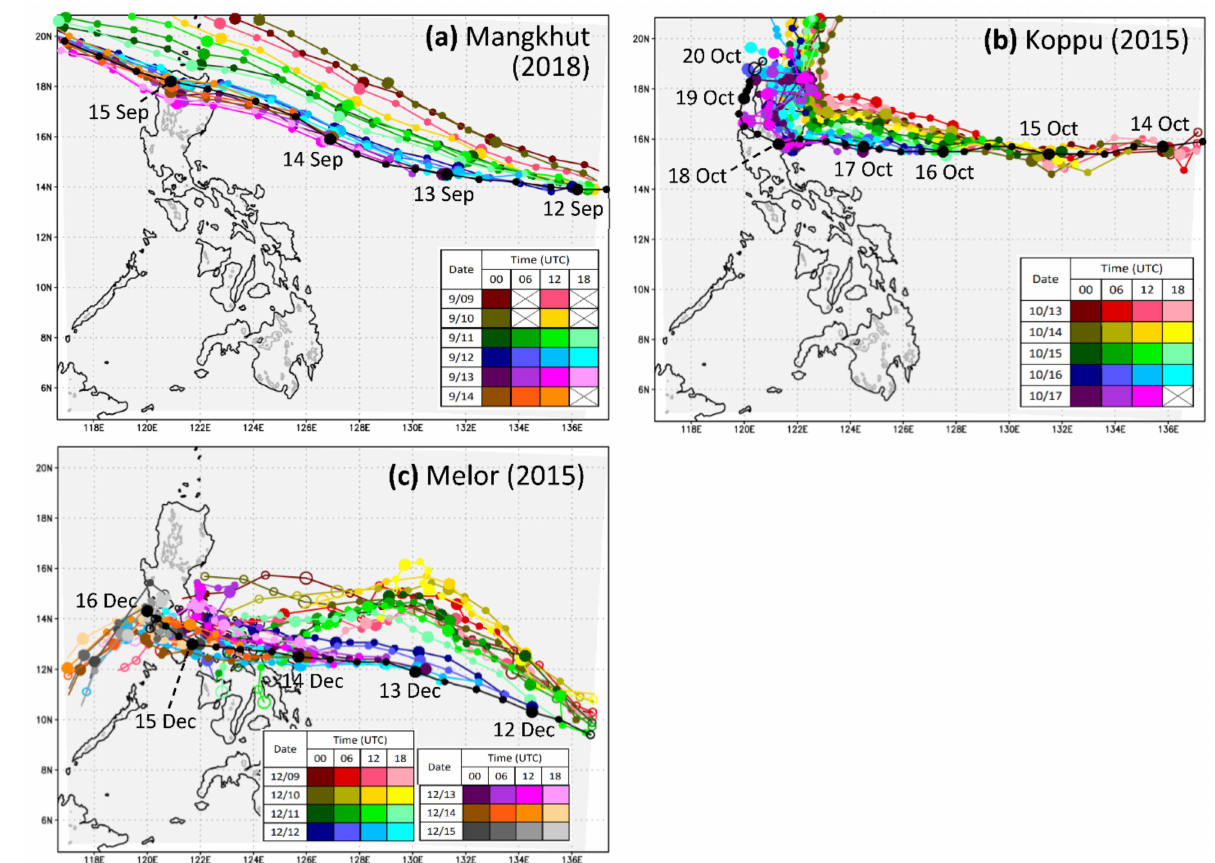
Figure 2. The JTWC’s best track (black) and predicted tracks (color, see inset) of ( a ) TY Mangkhut (2018), ( b ) TY Koppu (2015), and ( c ) TY Melor (2015) with time-lagged forecasts at different initial times. The model domain (light gray shading) and height contours at 1 km over land (dark gray) are also plotted (replotted from Part I